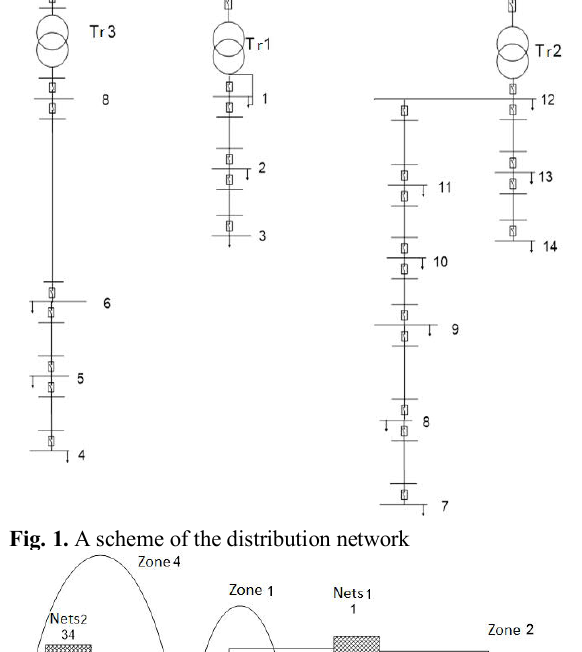
Fig. 1. A scheme of the distribution network